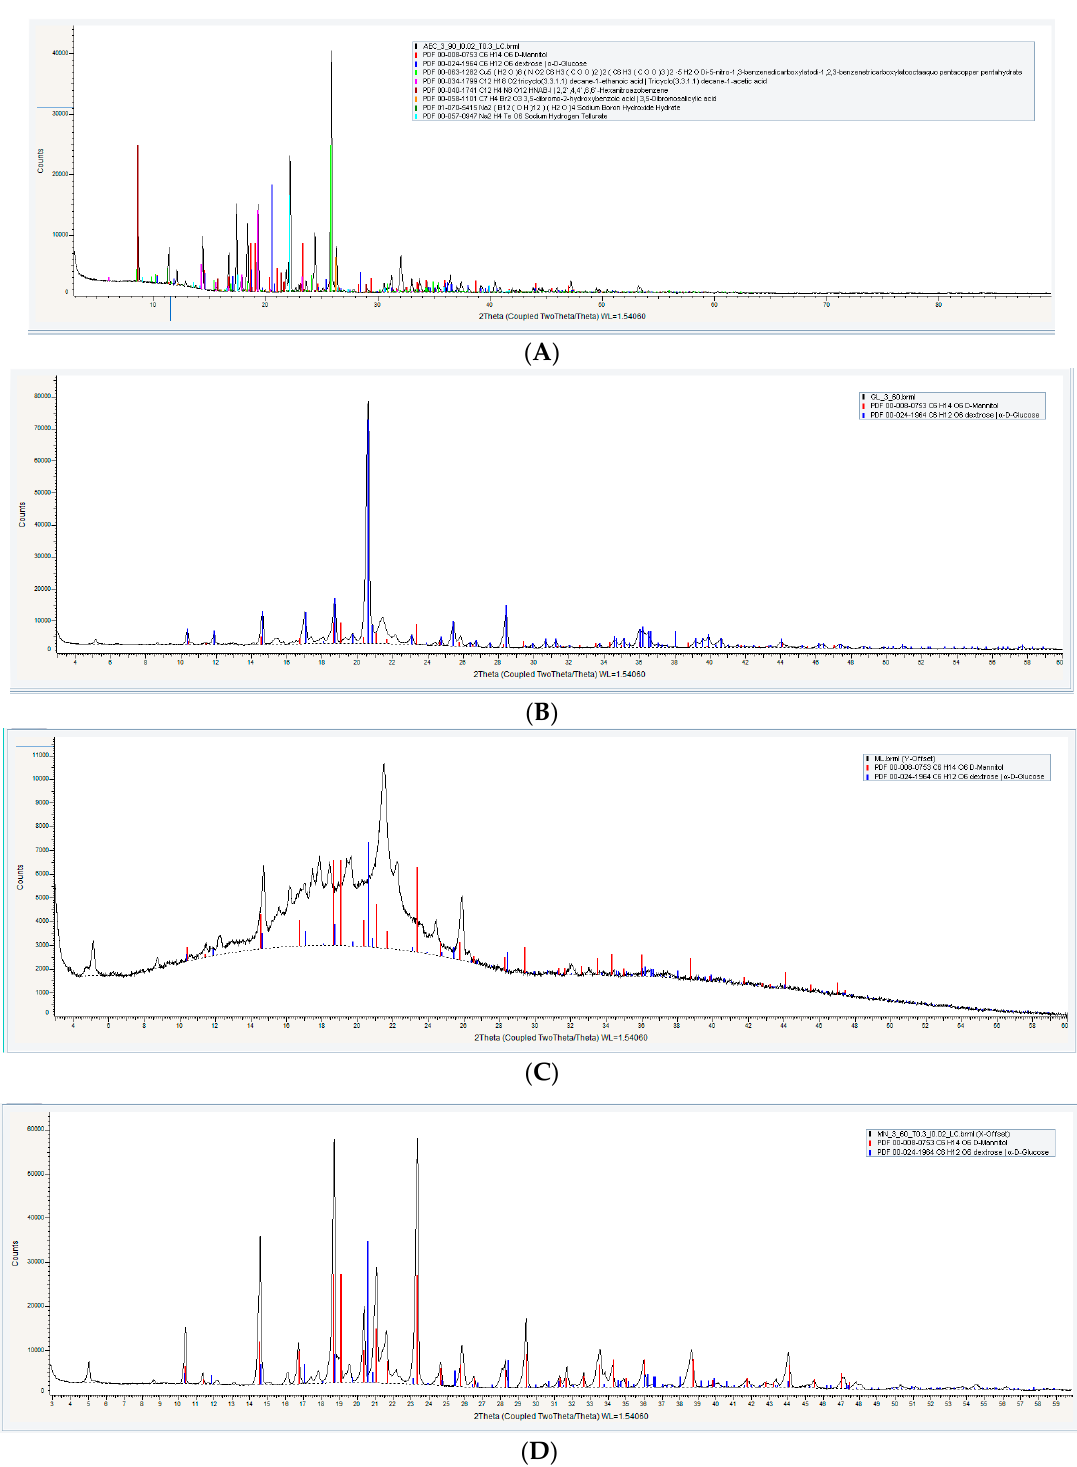
Figure 3. Powder X-ray Diffractometry XRD of ( A ) pure drug, ( B ) formula with glucose as a carrier (FN1), ( C ) formula with maltodextrin as a carrier (FN2), and ( D ) formula with mannitol as a carrier (FN3).